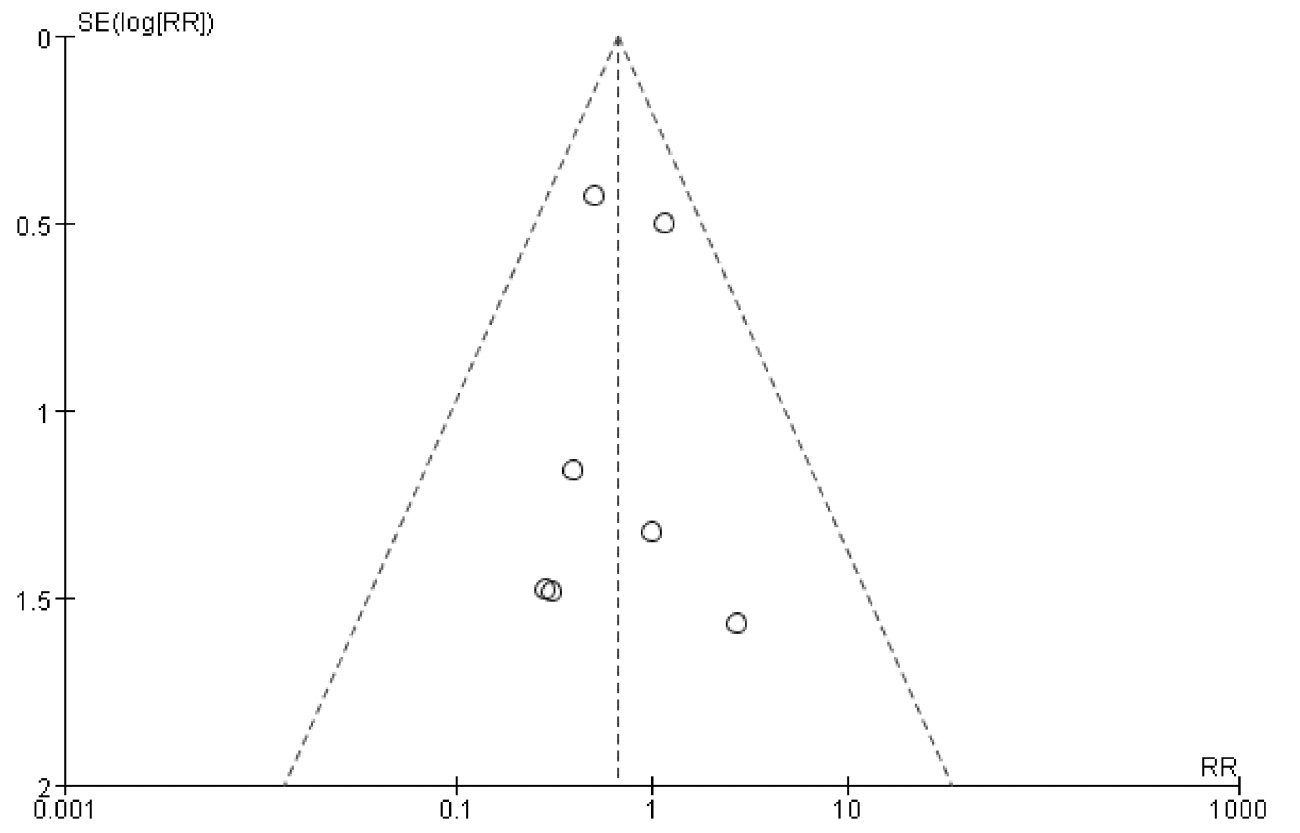
Fig 5. Funnel plot of the occurrences of reankylosis in the GA and IA groups, Egger ’ s test results: t = -0.12, p = 0.912.